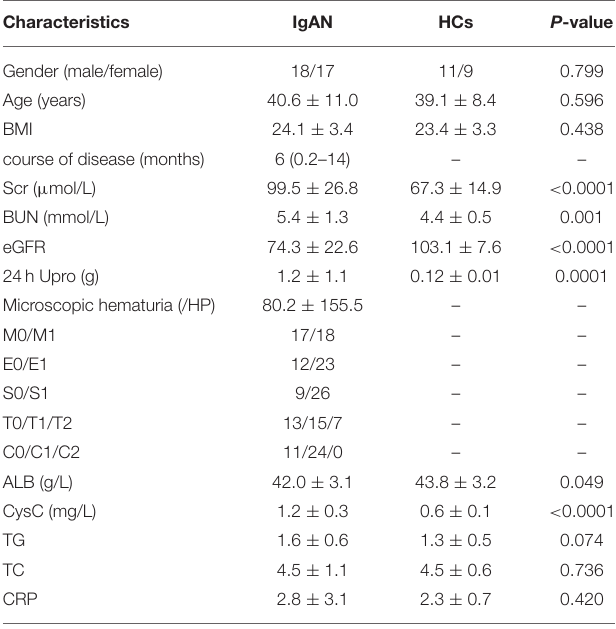
TABLE 1 | General data of experimental group and control